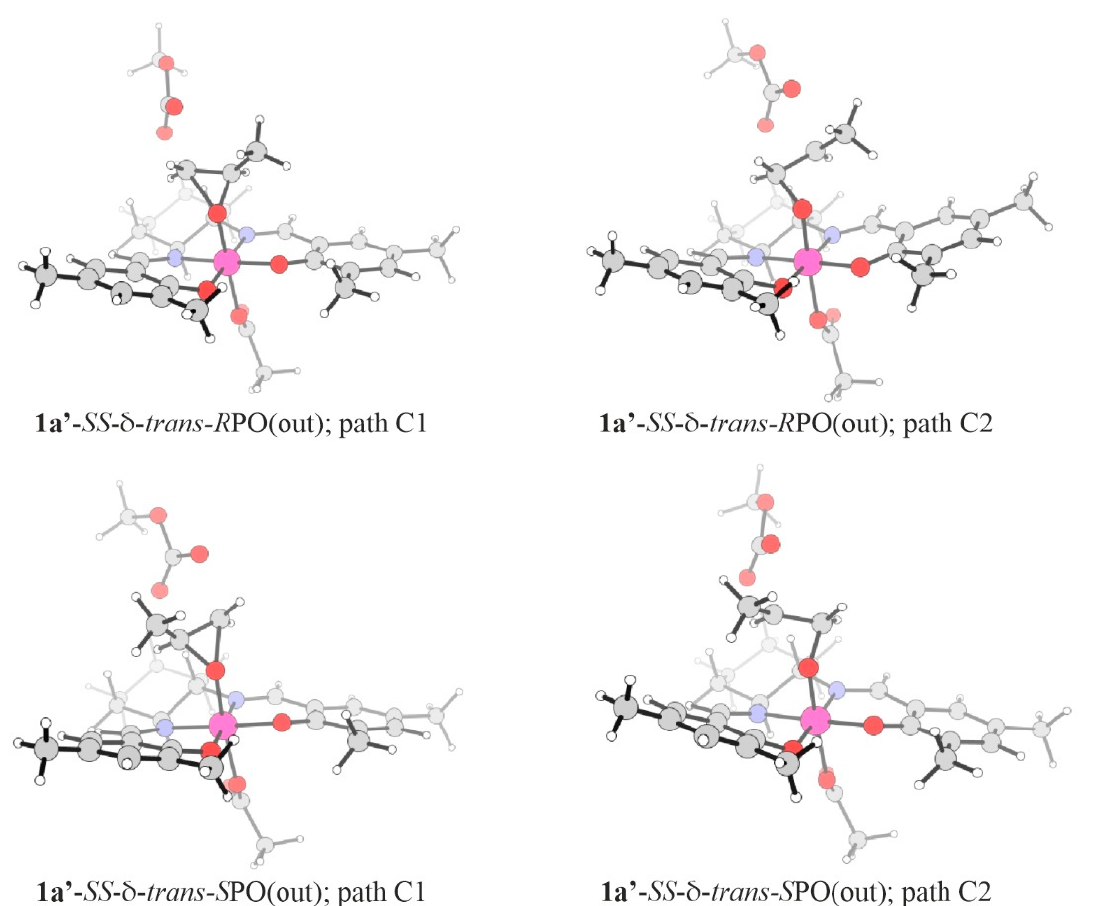
studied here, the product alkoxide complexes are by ca. 7–19 kcal/mol lower in energy than the corresponding starting prereactive complexes.